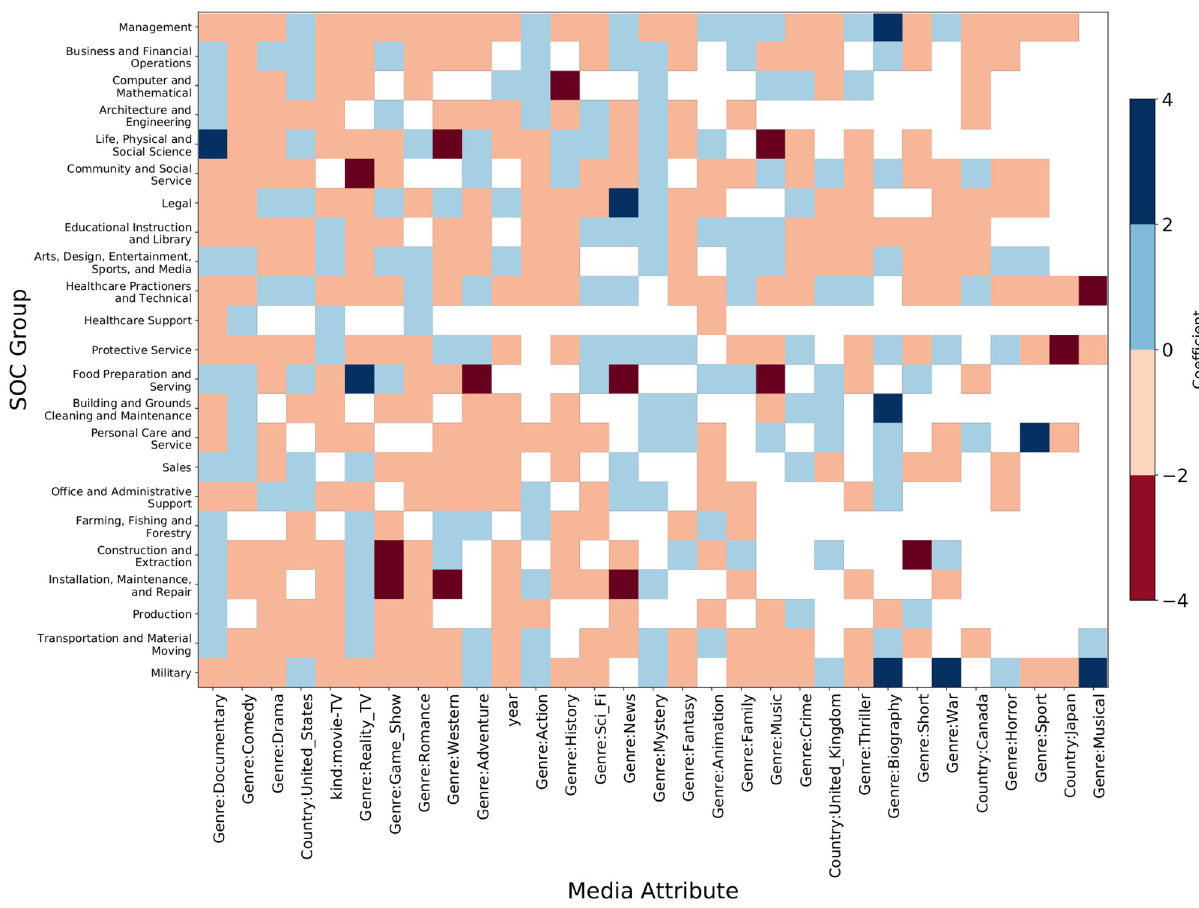
Fig 14. Heatmap of coefficient values of media attributes in predicting SOC group frequency. The color denotes the sign of the coefficient (blue = +, red = − ) and the intensity of the color is proportional to the magnitude of the coefficient. The blank cells indicate that the media attribute is not a significant predictor for the frequency of the corresponding SOC